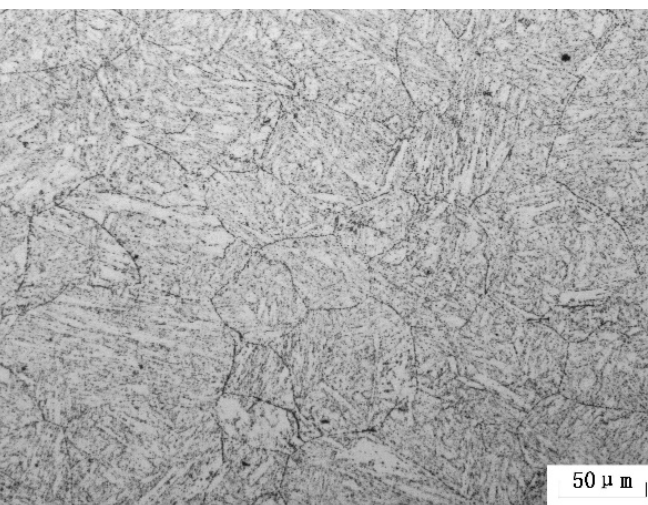
Figure 1. Optical microscopy of 9Cr-3W-3Co steel in the original condition (normalized and tempered). Table 1. Chemical compositions of the steels studied (mass %).